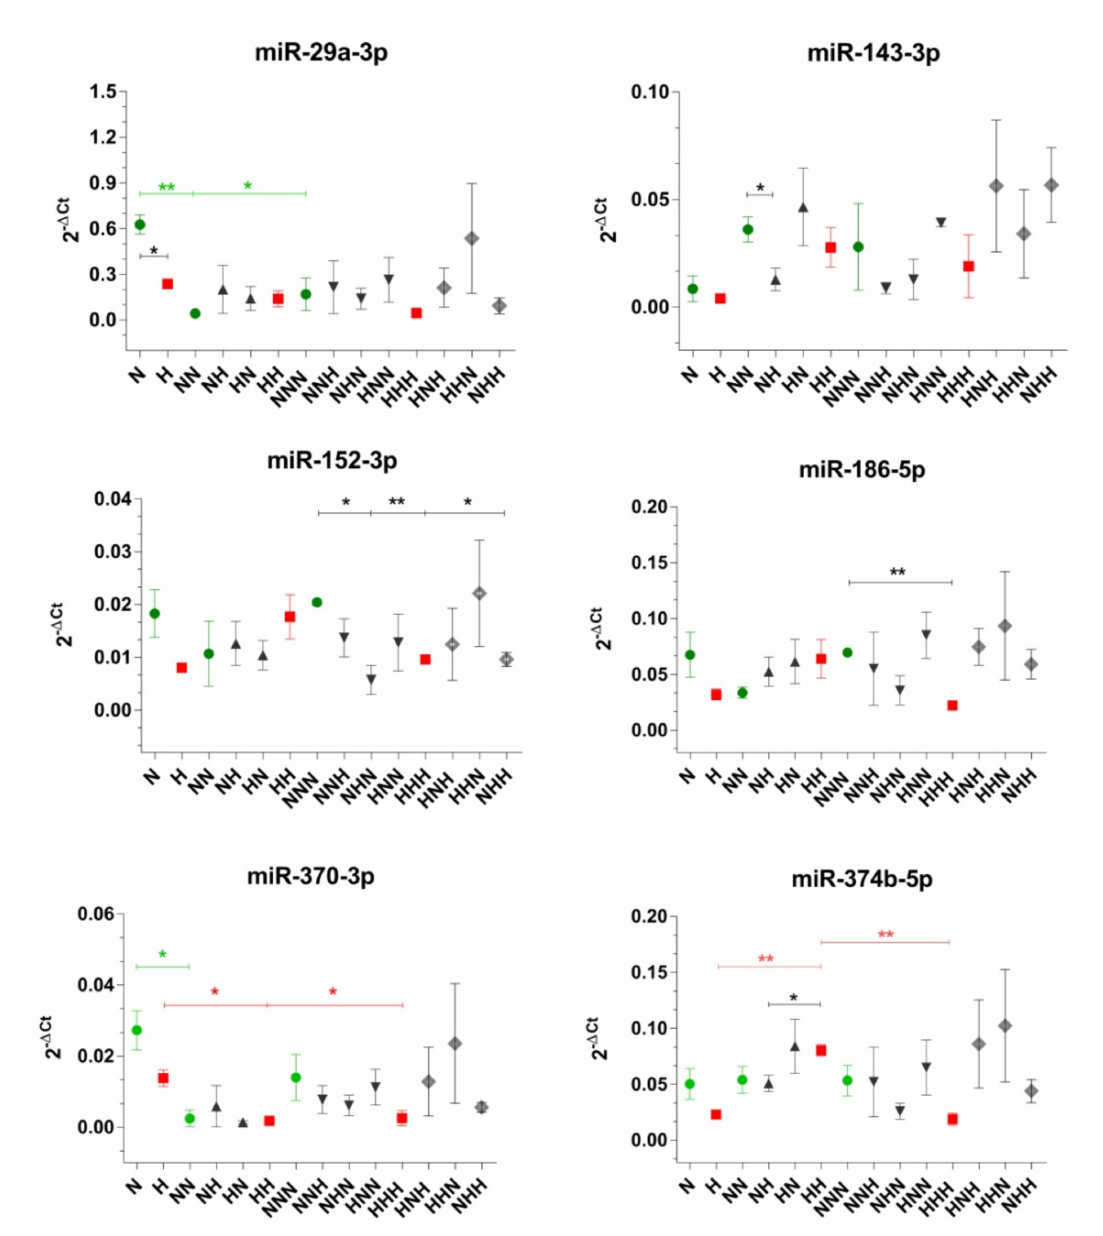
Figure 3. Expression profiles of miR-29a-3p, miR-143-3p, miR-152-3p, miR-186-5p, miR-370-3p and miR-374b-5p evalu- ated after completion of proliferation, differentiation, and maturation of visceral cells cultured in chronic/intermittent normoglycemic (N) and hyperglycemic (H) conditions. Data are expressed as mean ± SEM in green (NG), red (chronic HG), dark grey (single HG hit), and light grey (double HG hit). Differences in expression levels between two particular culture variants were evaluated using a two-tailed t -test. One-way ANOVA with a post-hoc Tukey test was used for the calculation of statistical significance of changes observed during ADG in NG and HG. (**): p ≤ 0.01; (*): p ≤